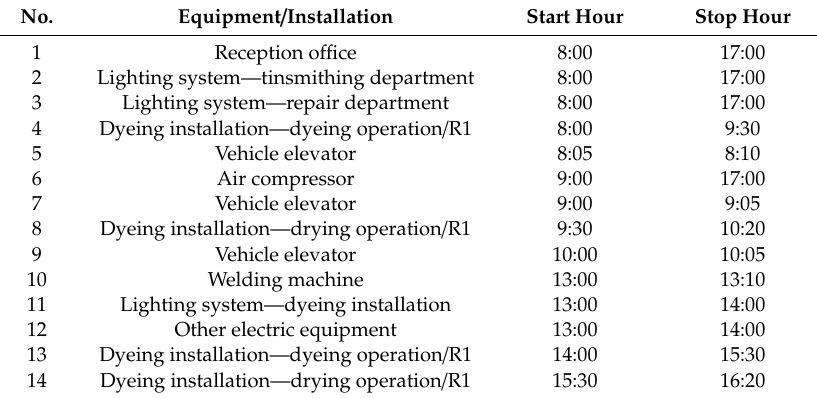
Table 12. The optimal production scheduling for analysed day